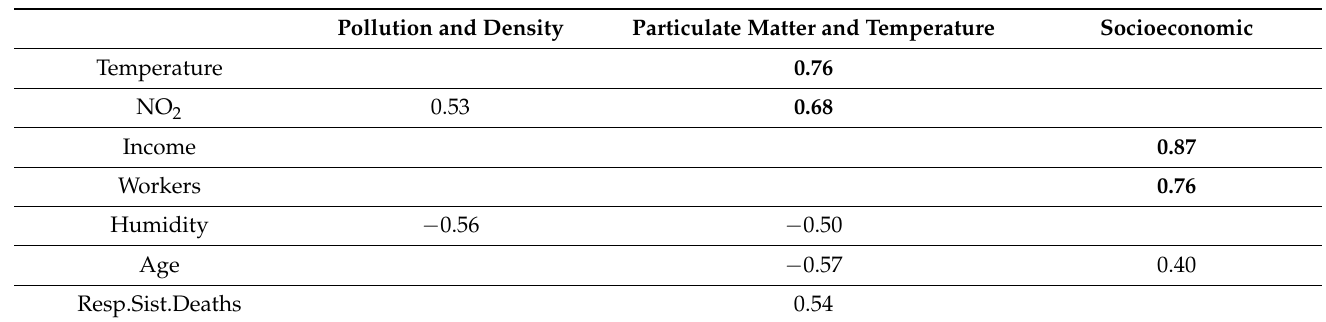
Figure 2. Components by clusters. Table 3 provides more detail on the characteristics of each cluster according to the mean scores of each of the original variables. The ANOVA p -values (Table 3) show that there are statistically significant differences between means in at least one cluster for all variables. Consequently, the post hoc test was employed to determine which clusters the differences existed between . The Madrid-City cluster was the most polluted region of the territory, followed by the Madrid-Surroundings cluster, while the North-East cluster